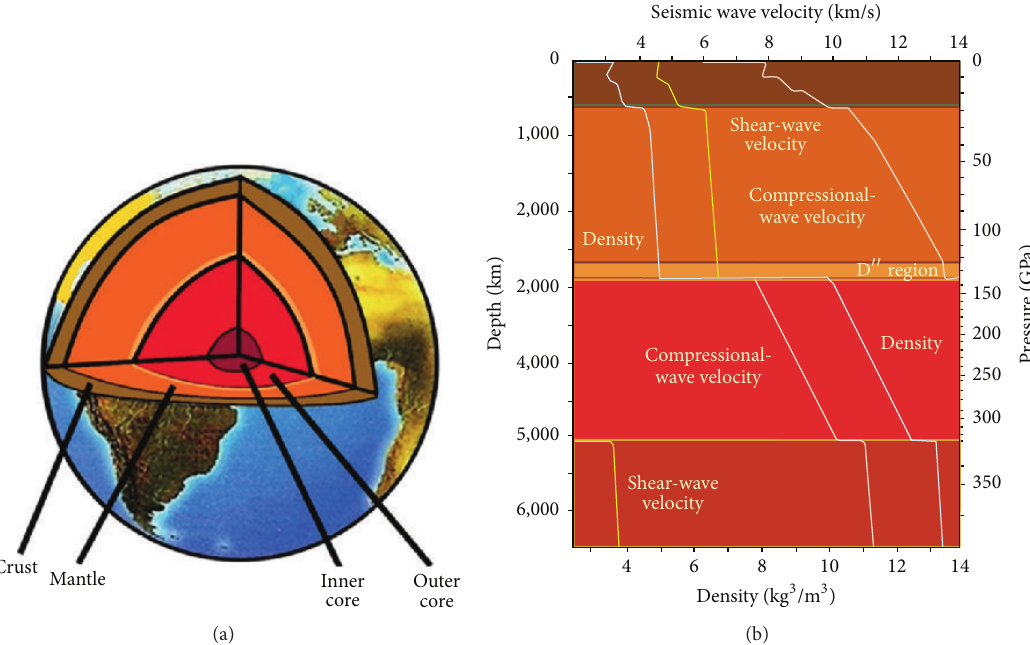
Figure 3: Density and seismic velocity variation with depth in Earth’s interior (adapted from Romanowicz